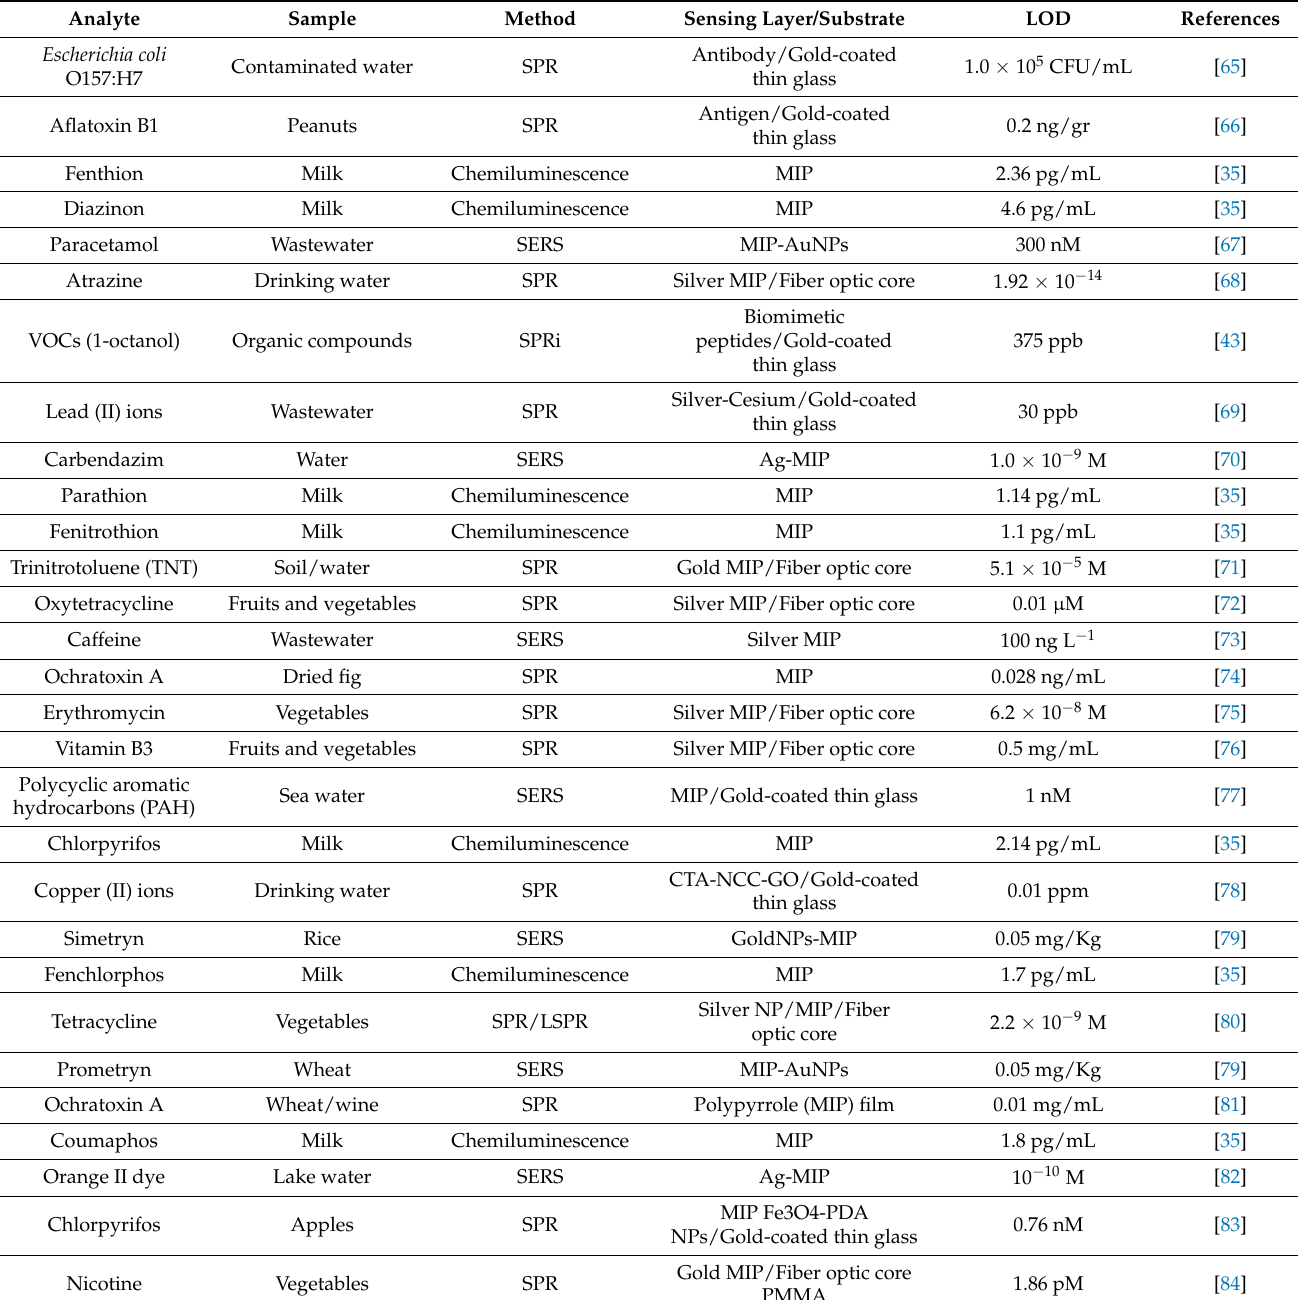
Table 1. Some reported MIP sensors in the literature developed with SPR and SERS for various environmental